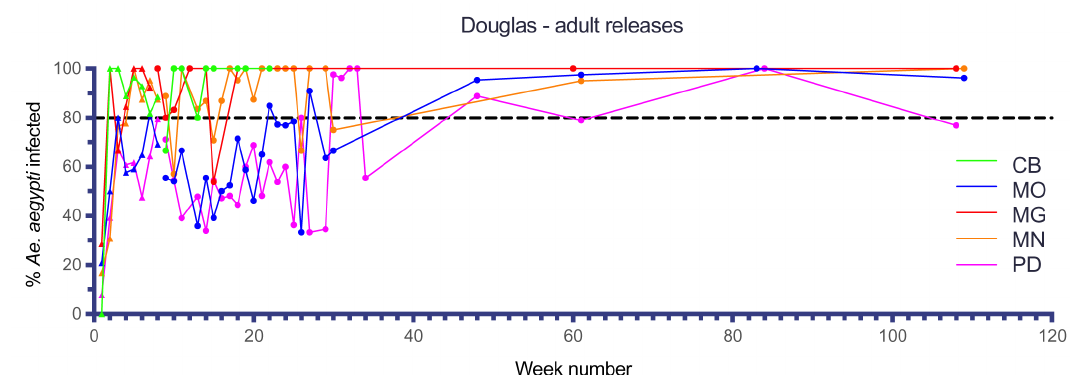
Figure 12. Wolbachia infection rates in Aedes aegypti mosquitoes collected from Cooya Beach (CB), Mossman (MO), Mossman Gorge (MG), Mossman North (MN) and Port Douglas (PD), during release (triangles) and post-release (circles) monitoring periods ( Wolbachia infected adult releases were undertaken every week for 7–8 weeks between Oct–Dec 2016, Week number 1 corresponds to commencement of Wolbachia mosquito